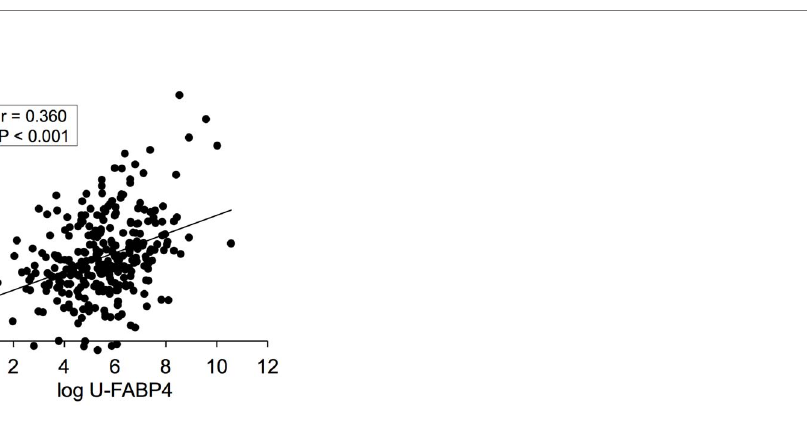
Fig. 1. Correlation between urinary FABP4 and albuminuria. Logarithmically transformed urinary albumin- to-creatinine ratio (UACR) was plotted against logarithmically transformed urinary FABP4 (U-FABP4) for